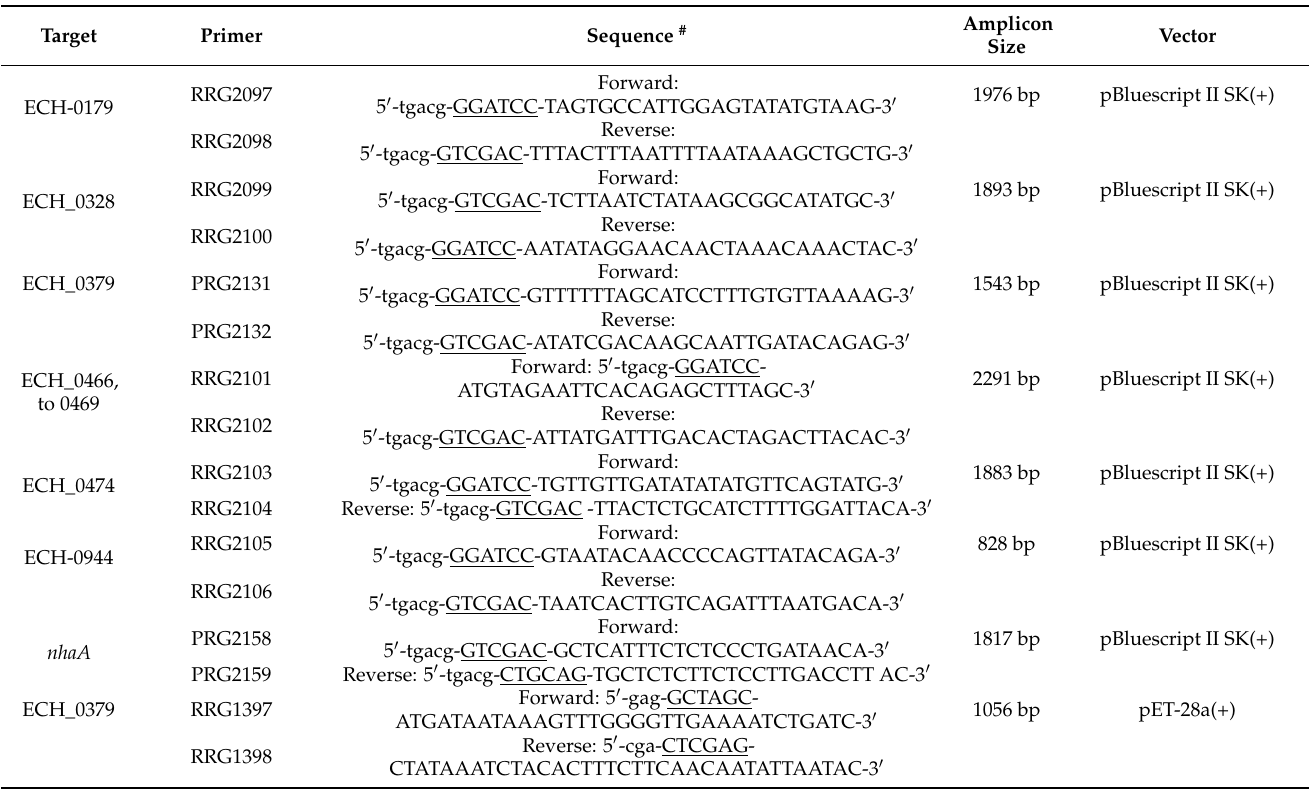
Table 3. Primers used for the recombinant